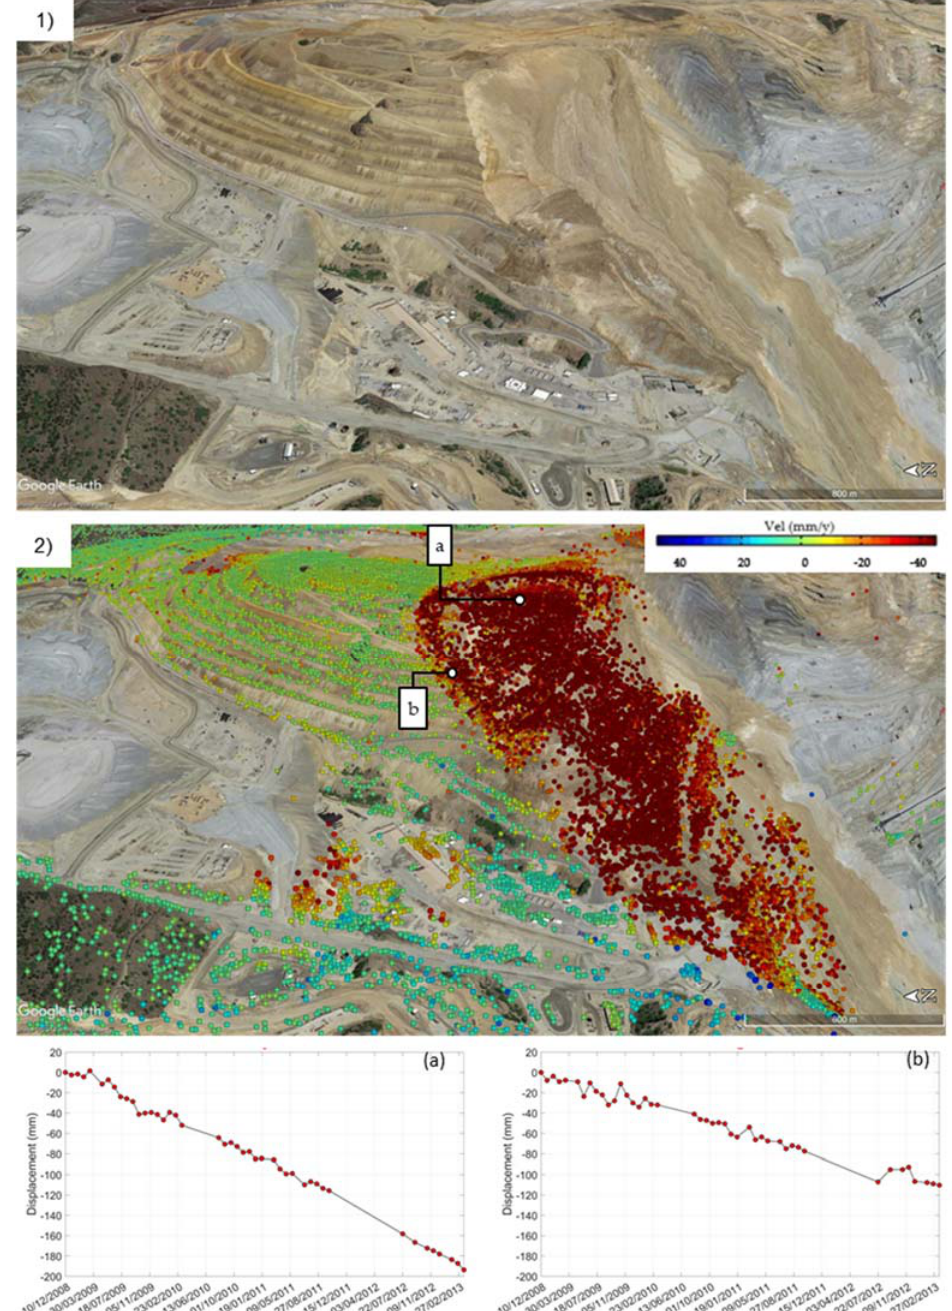
Figure 7. a) Landslide view from Google Earth. b) A ‐ DInSAR pre ‐ failure analysis for the Bingham Canyon Mine landslide over a 3D Google view reporting the landslide that occurred and time series of displacements for measurement points (a) and (b). (RADARSAT ‐ 2 Data and Products© MacDonald, Dettwiler and Associates Ltd. (year of acquisition)—all rights reserved. RADARSAT is an official trademark of the Canadian Space Agency; Lat: 40.534215°; Lon: − 112.145820°; WGS84).